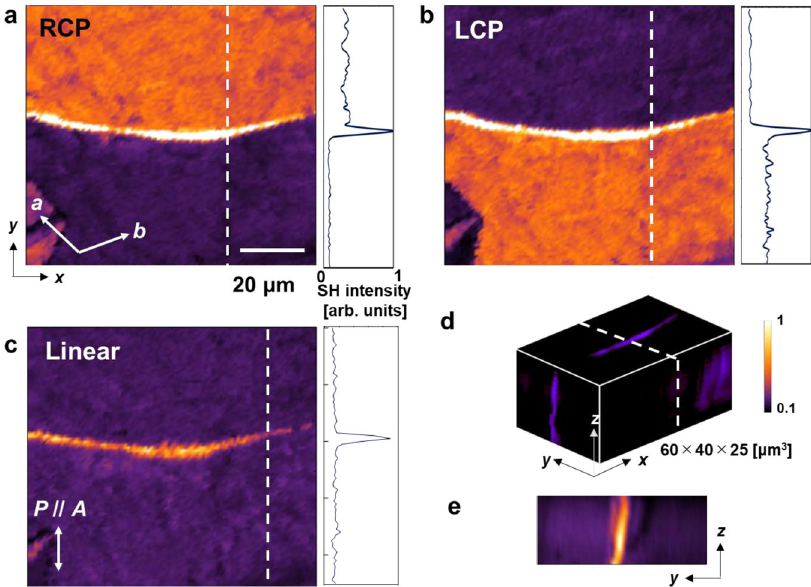
Fig. 3 Polarization dependence of circular intensity difference in second harmonic generation (SHG) around a ferroaxial domain boundary. a , b Two-dimensional maps of SH intensity obtained with ( a ) RCP, ( b ) LCP, and ( c ) linearly polarized fundamental light. Right panels of ( a – c ) show the pro fi les of SH intensity along the white dashed lines of the respective images. In ( a ), the crystallographic axes are indicated as white arrows. The white arrow embedded in ( c ) corresponds to the polarization directions of fundamental light and SHG. The upper and the lower areas with different SH intensities by measurements using circularly polarized light correspond to either A + or A − ferroaxial domains. Regardless of the light polarization, the SH intensity is enhanced at the domain boundary. d Three-dimensional image of SH intensity at the same area as ( a – c ). e Depth pro fi le in a plane cut at the white dashed line in ( d ). The bright line represents the depth pro fi le of the domain